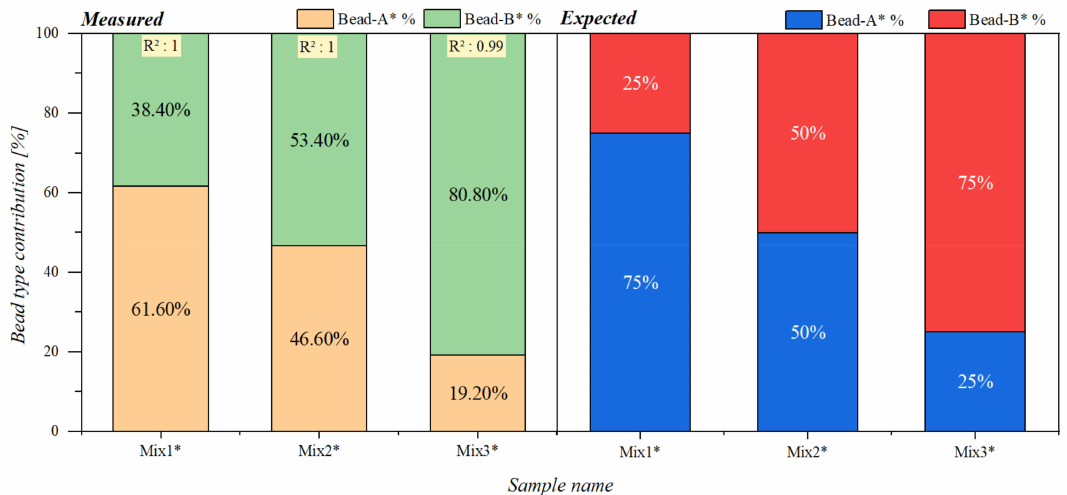
Figure 7. Bead type contributions for mixture samples containing beads A* and B*. The left chart presents the determined percentage of contributions from each reference bead type to the measured mixed samples. The right chart presents the expected contribution percentages of each bead type to the mixed